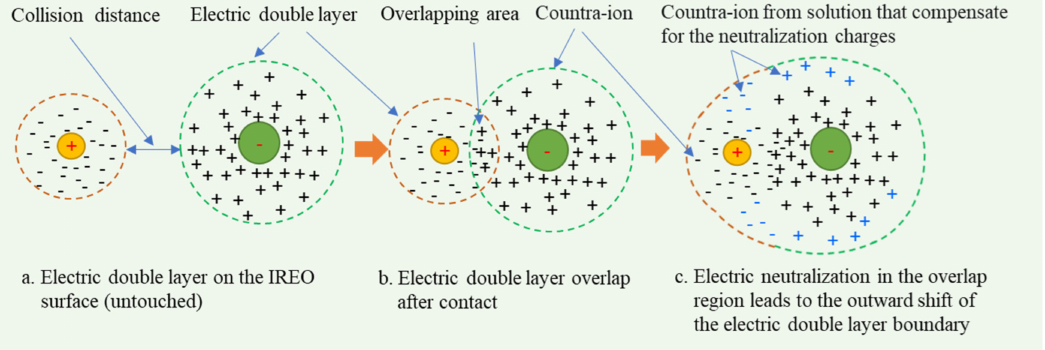
Figure 9. The overlapping of the double electric layer on the IREO colloidal surfaces during